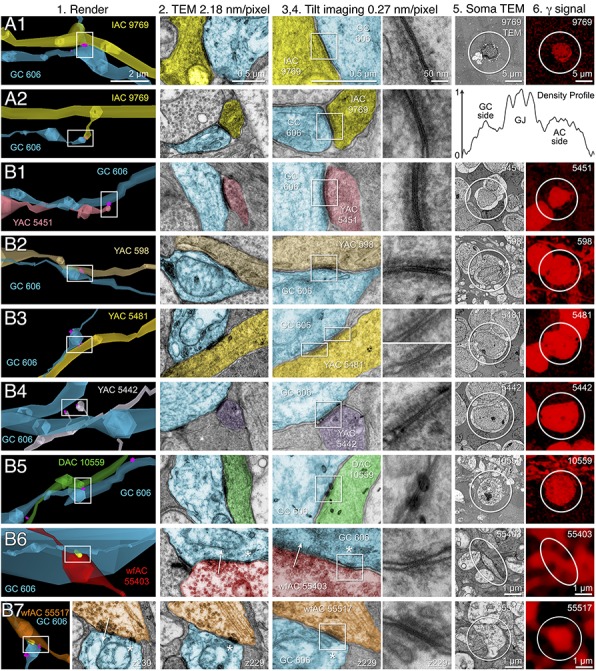
High-resolution analysis of coupling loci in Figure 9 imaged as: Column 1, VikingPlot renders; Column 2, RC1 native TEM at 2.18 nm/pixel; Columns 3 and 4, Goniometric reimaging at 0.27 nm/pixel; Column 5, soma or major process TEM; Column 6, GABA (γ) signal from the nearest intercalated CMP channel (Anderson et al., 2011b). (A1) Gap junction between GC 606 (cyan) and IAC 9769 (yellow). (A2) Gap junction between GC 606 (cyan) and IAC 9769 (yellow). Inset in columns 5,6 show a normalized plot of membrane density spanning the entire junction starting from the paramembranal density in GC 606, crossing the trilaminar zone and ending in IAC 9769 (ImageJ). (B1) Gap junction between GC 606 (cyan) and γ+ amacrine cell YAC 5451 (pink). (B2) Gap junction between GC 606 (cyan) and γ+ amacrine cell YAC 598 (tan). (B3) Gap junction between GC 606 (cyan) and γ+ amacrine cell YAC 5481 (yellow). (B4) Gap junction between GC 606 (cyan) and γ+ amacrine cell YAC 5542 (lavendar). (B5) Gap junction between GC 606 (cyan) and displaced γ+ amacrine cell DAC 5451 (green). Note that the lamination of the gap junction can be visualized through the inadvertent stain debris in column 4. (B6) Gap junction and adjacent conventional synapse between GC 606 (cyan) and wf γ+ amacrine cell wfAC 55403 (red). (B7) Gap junction and adjacent conventional synapse between GC 606 (cyan) and wf γ+ amacrine cell wfAC 55517 (orange).